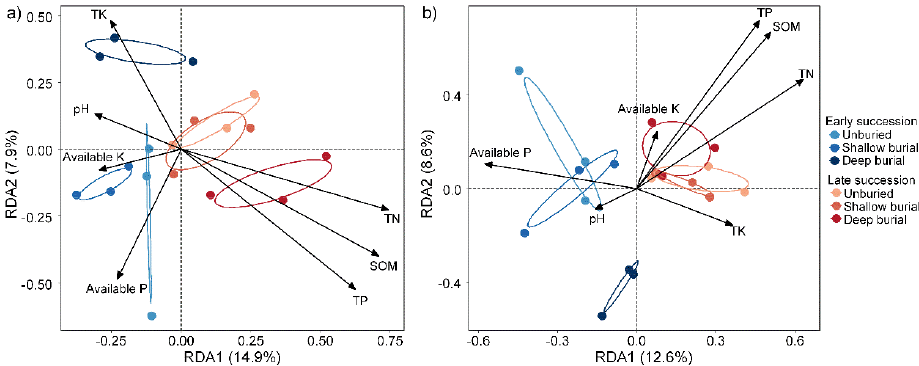
Figure 7. Distance-based redundancy analysis (RDA) of the relationship between the environmental factors and ( a ) bacterial and ( b ) fungal communities.